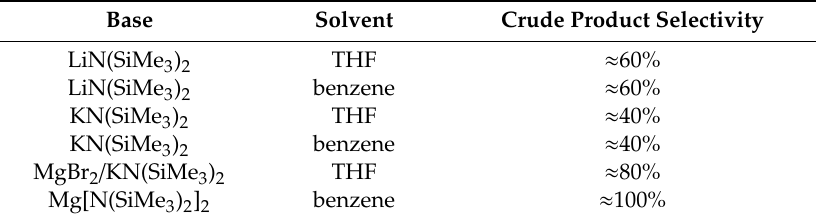
Table 1. Product selectivity using di ff erent solvents and transmetalating